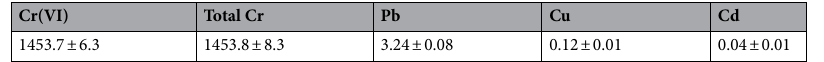
Table 1. The concentrations of heavy metals in chromium wastewater (mg L −1